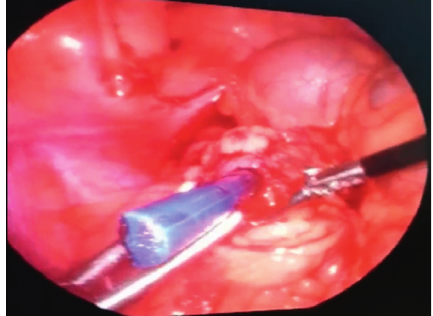
Figure 2: Laparoscopy view demonstrating foreign body (paint- brush) in the